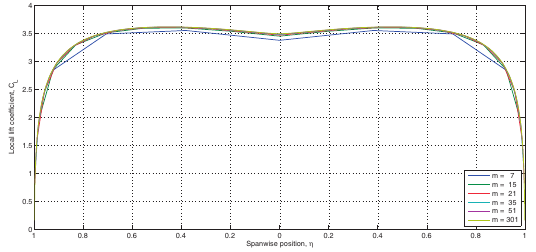
Fig. 7. Local lift coefficient C L resolution with a different number of aerodynamic strips (Andrews